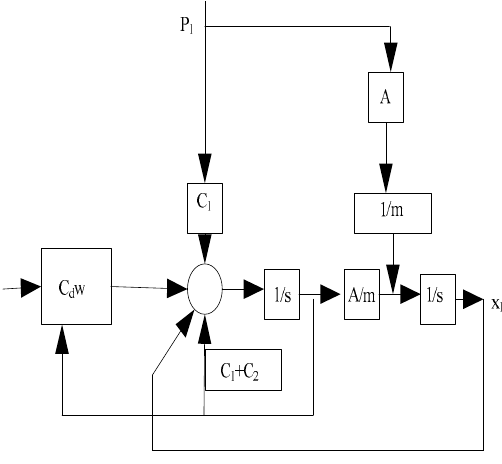
The structural diagram of the hydraulic system is shown in Figure 4.